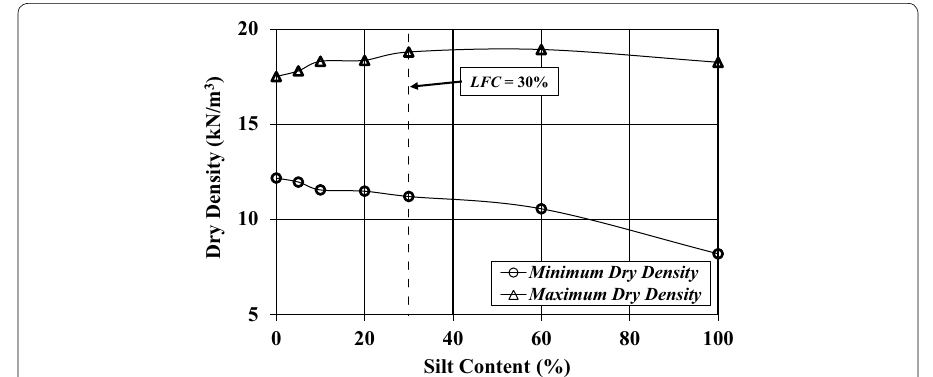
Fig. 4 Variation of maximum and minimum index dry density of sand–silt